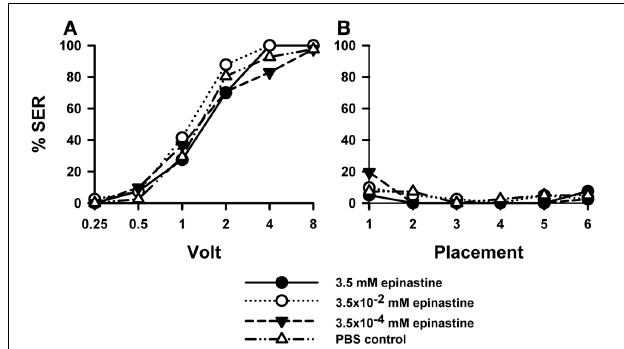
FIGURE 2 | Effects of OA blocking on aversive responsiveness. Three different groups of bees were injected with three different concentrations of the OA antagonist epinastine (3.5mM: n = 40; 3.5 × 10 − 2 mM: n = 41; 3 . 5 × 10 − 4 mM: n = 41). A fourth group was injected with PBS as a control ( n = 41). Sting responsiveness was measured in response to increasing voltages during shock trials (A) and during placement trials in which the bees were placed in the setup without stimulation (B) . All three epinastine concentrations induced the same responsiveness as the PBS control both in the shock and in the placement trials, thus showing that OA does not play a significant role in sting responsiveness to a noxious